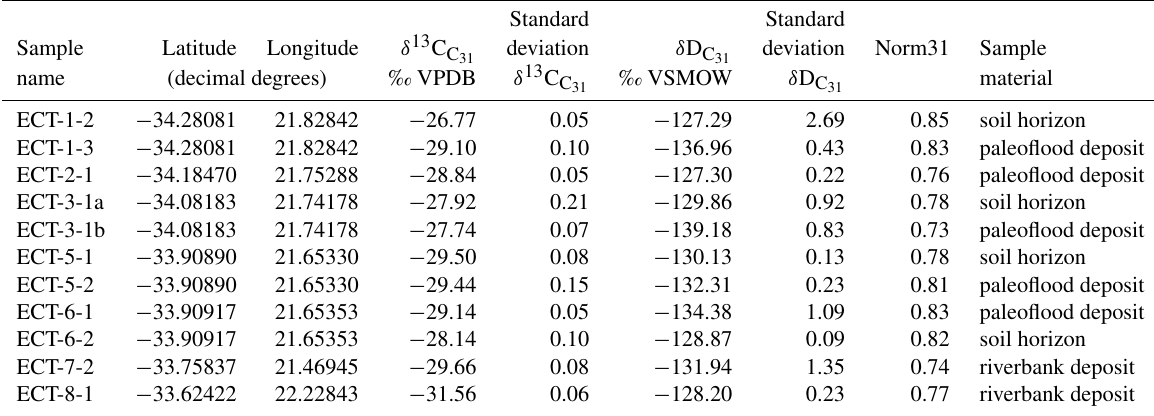
Table 2. n -Alkane isotopic composition and distribution descriptive parameters averaged (with standard